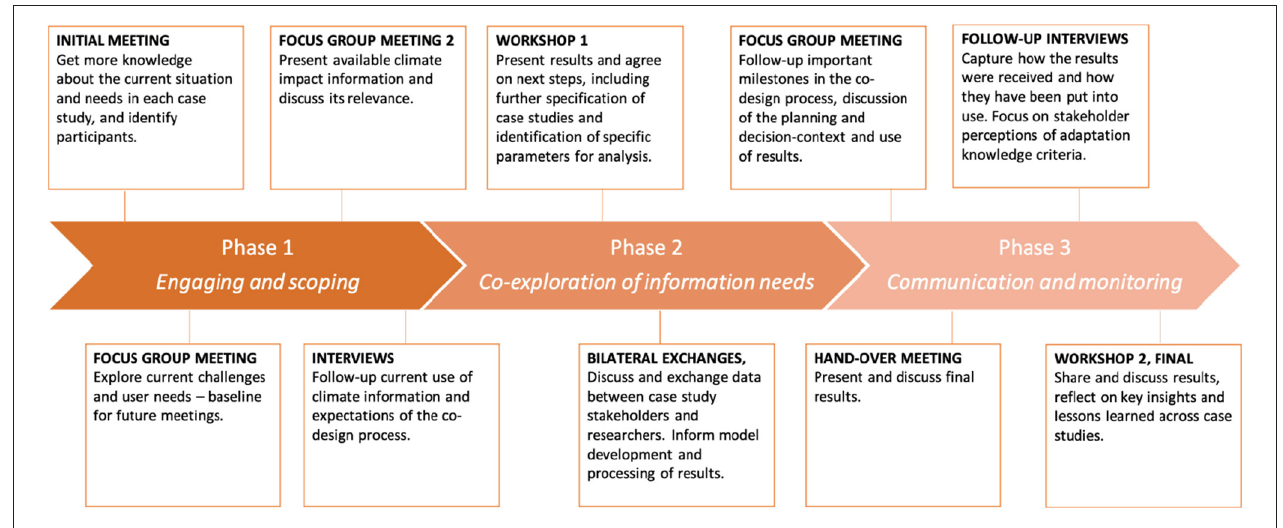
FIGURE 1 | Overview of HazardSupport co-design process.